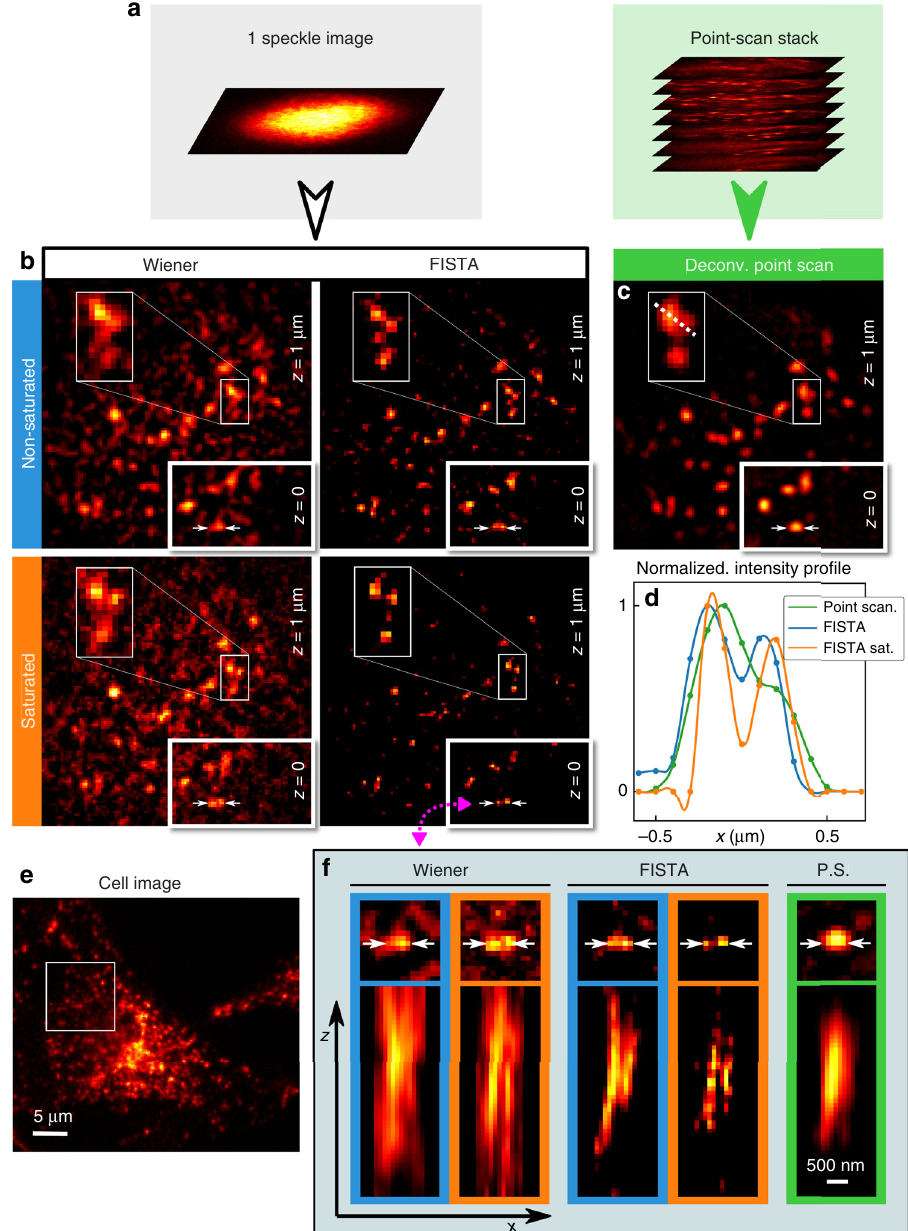
Fig. 3 Images of lysosomes in fi xed cultured cells. A region of interest materialized by a white square in the wide fi eld view ( e ) was imaged both by 2D speckle scanning and 3D point scanning ( a ). Regions of two 1 μ m distant transverse planes from the 3D reconstruction of fl uorescence distribution are shown in ( b , c ), in three imaging modes: nonsaturated and saturated ( 〈 s 〉 ≃ 1.4) speckle imaging ( b ) as well as 3D deconvolved point scanning c . Reconstruction from speckle images is performed both by Wiener deconvolution and by the FISTA compressed sensing algorithm, for comparison. FISTA reconstruction suppresses noise arising from out-of-focus fl uorescent objects. The line pro fi le corresponding to the white dotted line in ( c ) is plotted in ( d ) (with quadratic interpolations) and compared to corresponding pro fi les obtained with FISTA reconstruction. White arrows at plane z = 0 pin-point two vesicles that can only be resolved under saturated conditions. Cross-sections of these two vesicles are shown in ( f ). All images were acquired using NA =